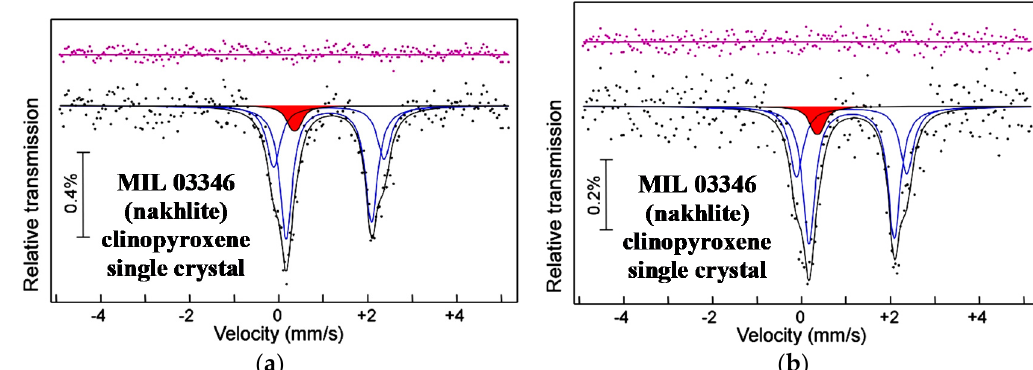
Figure 15. Room temperature Mössbauer spectra of MIL 03346 augite (clinopyroxene) single crystal at two different orientations ( a , b ). Indicated components are the results of the fits. The ferric component is shaded in red. The differential spectra are shown on the top. Adapted from [37].